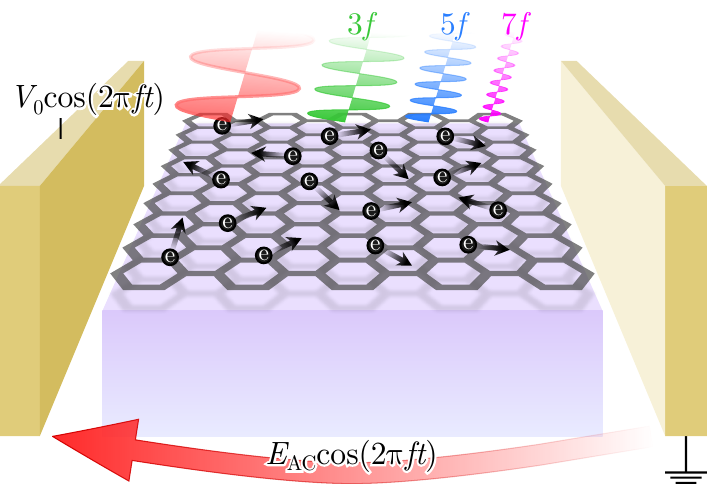
Figure 1. Depiction of the emission of harmonic radiation as a consequence of the oscillating electric field applied over a monolayer graphene